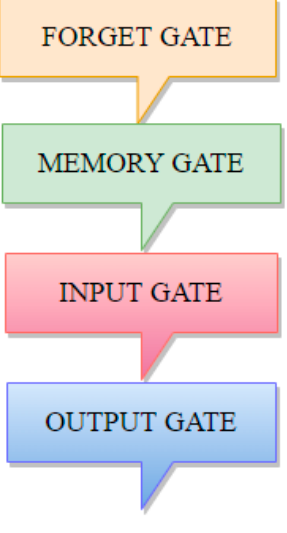
Figure 7. Long short term memory cells.